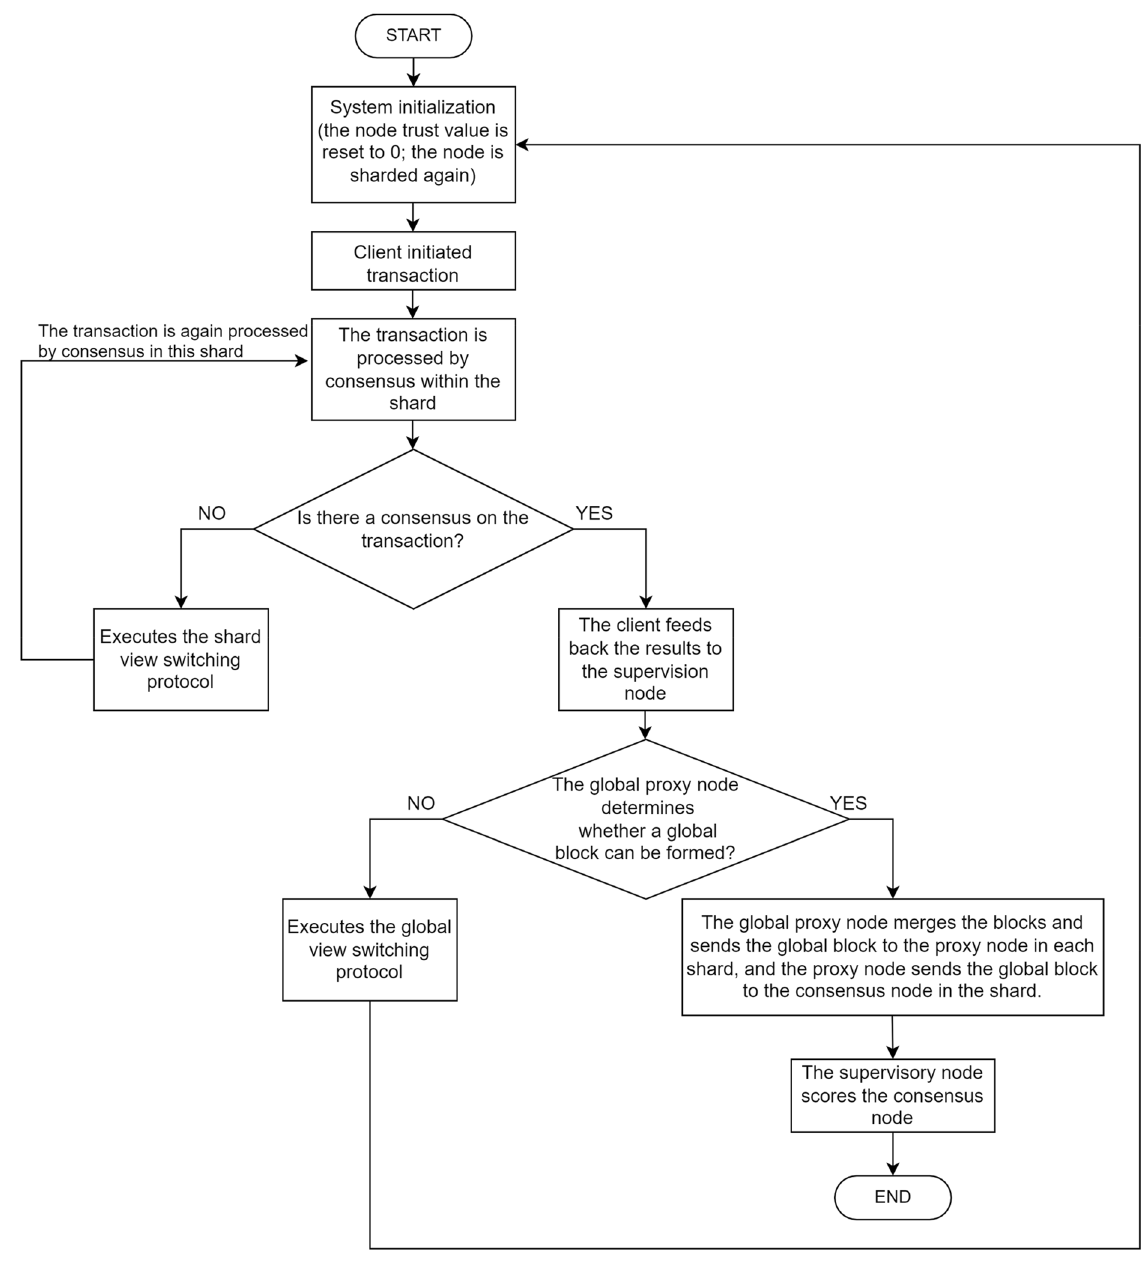
Figure 4. System flow chart of KBFT